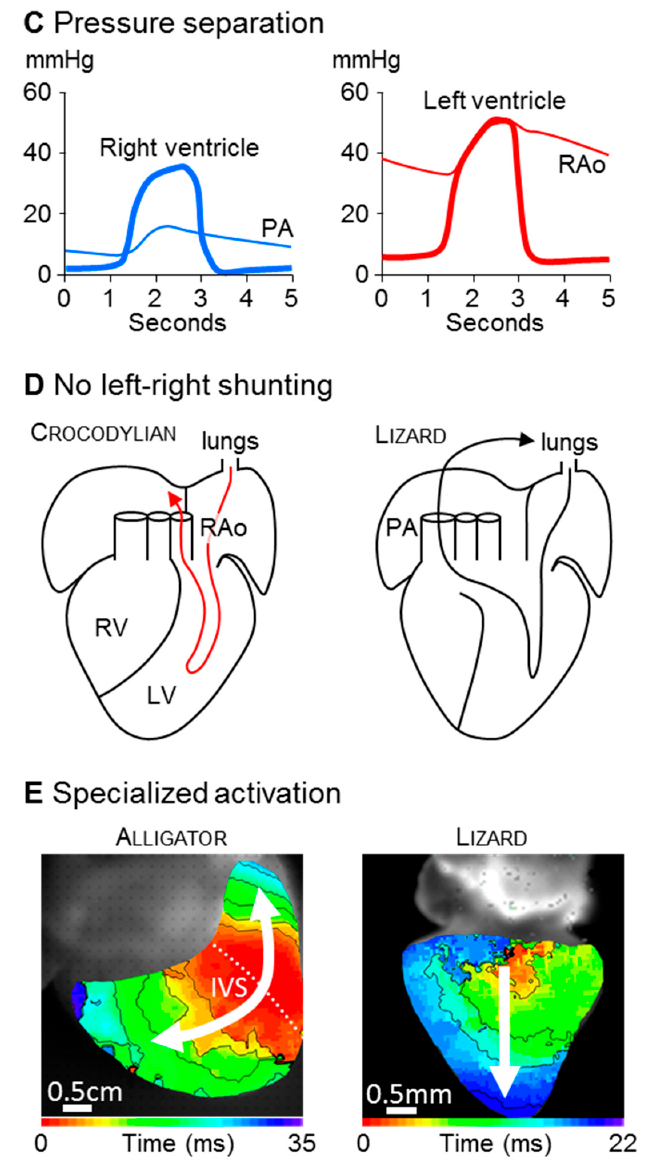
Figure 1. Consequences of the crocodylian ventricular septum at the level of the organ. ( A ) Both the left (LV) and right (RV) ventricle of crocodylians are extensively trabeculated. Adapted from [32], figure 10. ( B ) Histology shows the ventricular wall can be seen to consist of a thin outer shell of compact myocardium and an extensive layer of trabeculated myocardium (trab). The ventricular septum consists of a thin layer of tightly-organized myocardium (red arrowheads). Adapted from Reference [11], table IX, figure 11. ( C ) Blood pressures of the left and right ventricle and major arteries. Notice that the pulmonary artery (PA) has much lower pressures than the aorta (RAo). Redrawn from [16], figure 3b. ( D ) In crocodylians, blood returning from the lungs is always ejected through the right aorta (RAo) and left-to-right shunts are, therefore, impossible anatomically. In contrast, in non-crocodylian reptiles (here exemplified by a lizard), there is no full ventricular septum and the pulmonary venous blood can be shunted back to the lung circulation through the pulmonary artery. ( E ) Optical mapping of electrical activation (depolarization). The pattern of ventricular activation is specialized in the crocodylian ventricle compared to the setting of non-crocodylian reptiles (e.g., lizard) as it spreads laterally from the ventricular septum (IVS) rather than from the base to the apex. Adapted from References [14,23].